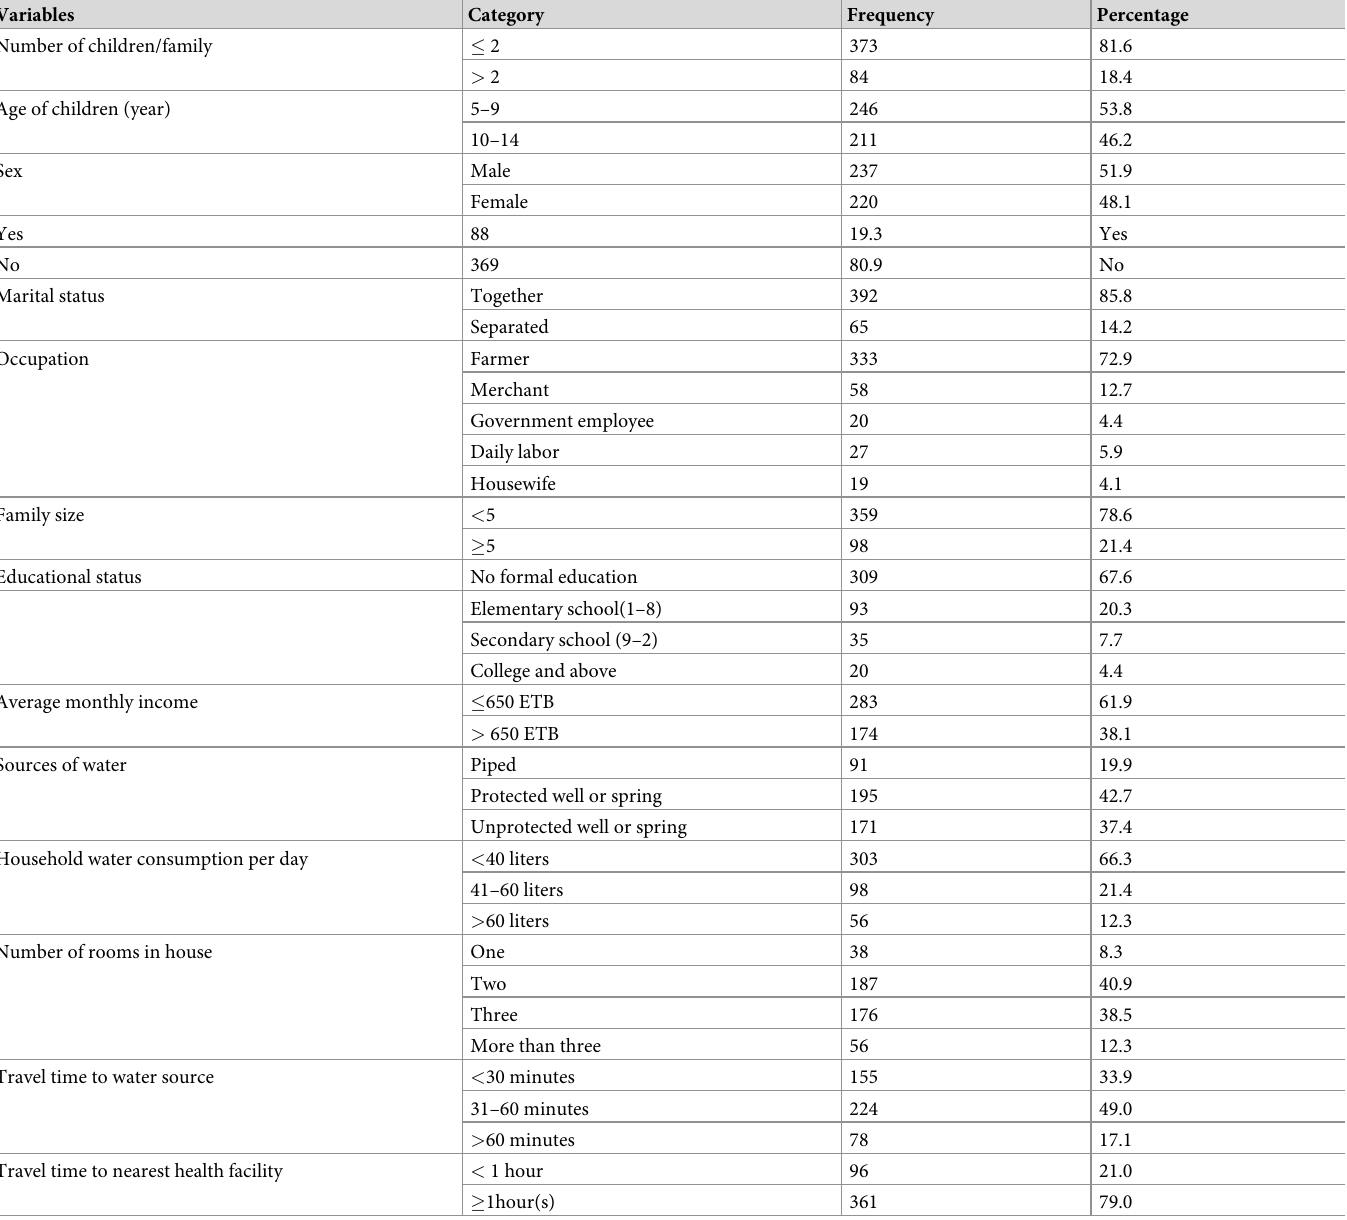
Table 2. Socio-demographic characteristics of caregivers, Meta Robi District, Ethiopia